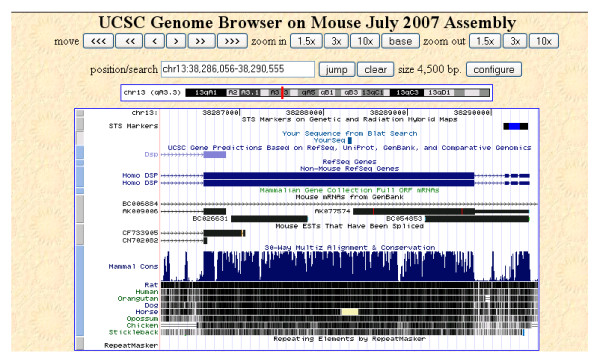
Genomic mapping of mouse peptide LLEAQIATGGIIDPK using UCSC Blast program. Mouse splice variant M13C2563_1_s386_e8960_1_rf2_c1_n0 was identified with 13 distinct peptides. Twelve peptides matched a predicted mouse protein similar to desmoplakin using a homolog search against the NCBI NR database. However, all 13 peptides were homologous to the human desmoplakin sequence. Of note, mouse peptide LLEAQIATGGIIDPK aligns to the coding sequence of human desmoplakin, but not to the annotated mouse desmoplakin gene.